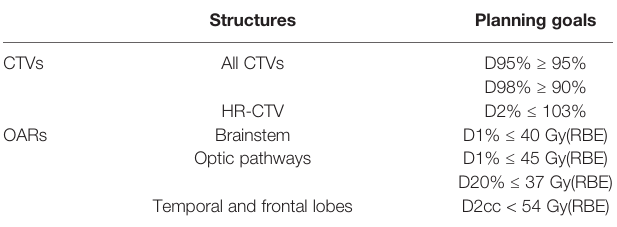
TABLE 2 | Main planning goals for volumes of interest.